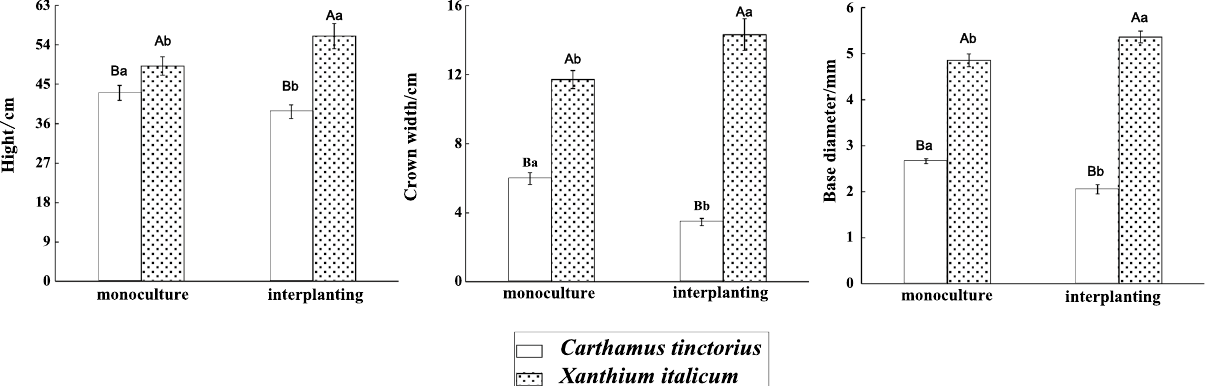
Figure 1. Morphological indicators of X. italicum and Carthamus tinctorius (mean ± SE). Different capital letters in the figure indicate significant differences between monoculture and interplanting treatments; different lowercase letters indicate significant differences between the two plants under the same planting pattern ( P <